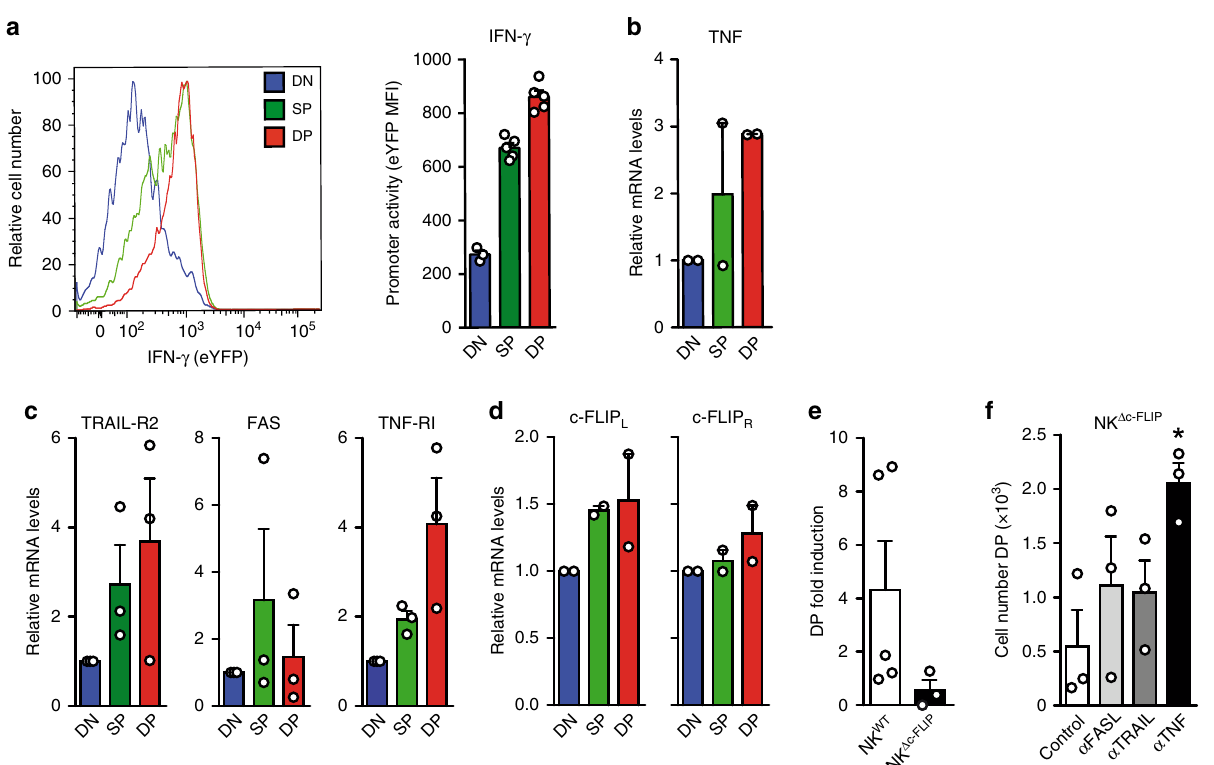
Fig. 2 The generation of NKp46 + ILC requires c-FLIP-mediated protection from TNF-induced apoptosis. a To determine Ifng promoter activity in unstimulated ILC precursors, freshly isolated BM cells from eYFP-transgenic IFN- γ reporter mice were analyzed by fl ow cytometry. Mean fl uorescence intensities (MFI) were determined for eYFP after gating on Lin − CD122 + DN, SP, and DP cells. Representative histograms and pooled results (bar diagrams, mean + SEM) from two independent experiments with a total of fi ve mice are shown (DN = 3 data points). b – d Lin − CD122 + DN, SP, and DP cells were FACS-puri fi ed from BM of B6 mice and the indicated mRNAs were quanti fi ed by RT-qPCR. mRNA levels of DN cells were set to 1 and all other values were calculated in relation. Shown are pooled results (mean + SEM) from b , d two and c three independent experiments. e , f Lin − CD122 + DN cells from e NK WT and NK Δ c-FLIP mice or f NK Δ c-FLIP mice alone were enriched by FACS-sorting. f To block DR-function, α FASL, α TRAIL, or α TNF antibodies were added to the indicated cultures. e , f After 9 days of culture, numbers of viable DP cells were calculated in relation to those at day 0. f Absolute cell numbers are shown. Data (mean + SEM) were pooled from 3 – 5 independent experiments. a – f Source data are provided as source data fi le; e , f * p ≤ 0.05; ** p ≤ 0.005; *** p ≤ 0.001; **** p ≤ 0.0001 (paired Student ’ s t (Fig. 3a, e) including T-bet + ILC1 (Fig. 3b, e), NK1.1 + Eomes + cNK (Fig. 3c, e) and NKp46 + ROR γ t + ILC3 (Fig. 3d, e) were strongly reduced in the SI of NK Δ c-FLIP mice. Importantly, numbers of NKp46 − CD4 + / − ROR γ t + ILC3 (Fig. 3d, f) and NKp46 − GATA3 + ILC2 (Fig. 3f) remained unaltered in NK Δ c-FLIP mice. Hence, NK Δ c-FLIP mice lack NKp46 + ILC but have normal numbers of NKp46 − ILC in the SI. Similar data were obtained with NK Δ STAT5 mice (Fig. 3g, h) further emphasizing the functional link between STAT5 and c-FLIP.